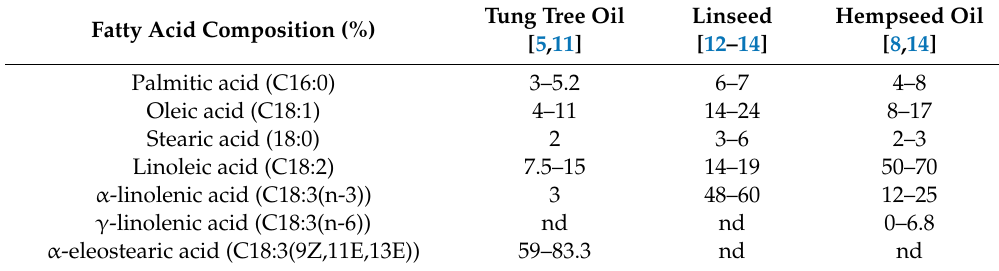
Table 1. Composition of the drying